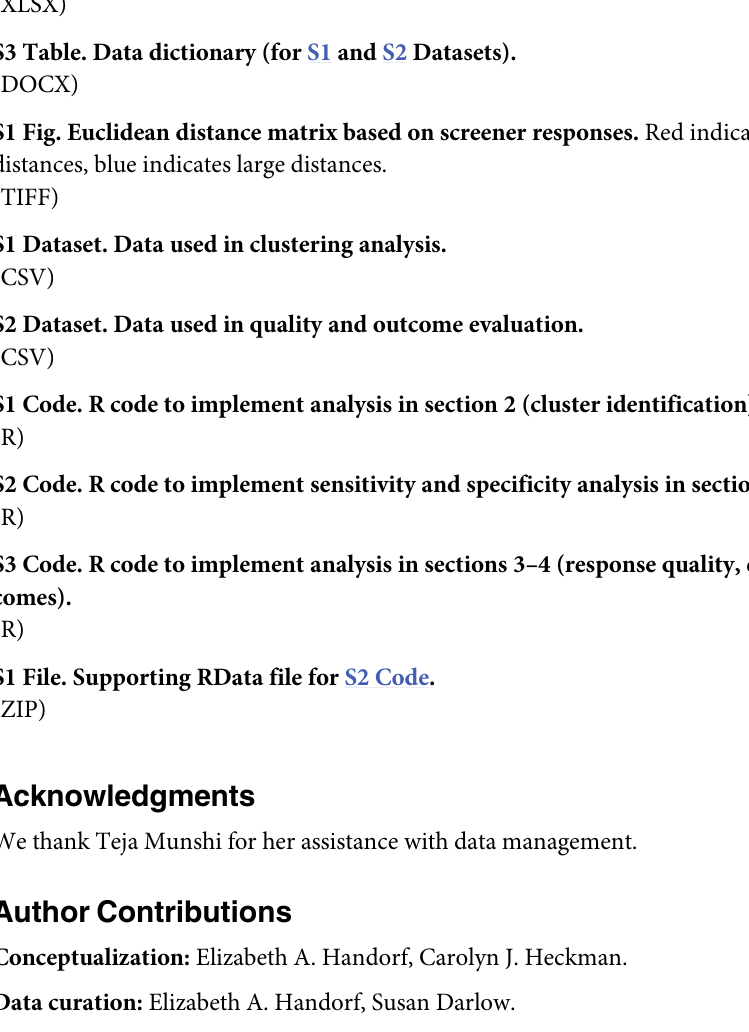
S1 Table. Table of screening questions from the BRAT scale. (DOCX) S2 Table. Quality measures in detail. S3 Table. Data dictionary (for S1 and S2 Datasets). S1 Fig. Euclidean distance matrix based on screener responses. Red indicates small pairwise distances, blue indicates large distances.